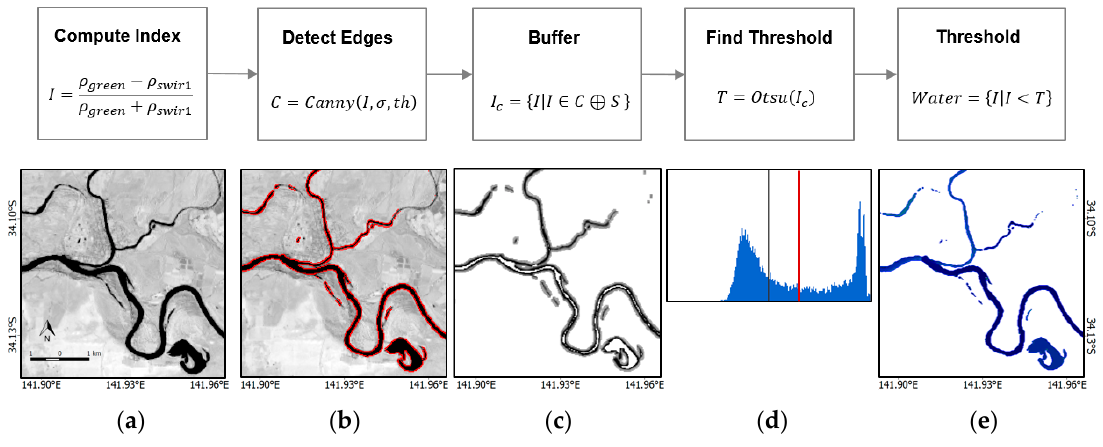
Figure 9. Method of water detection, consisting of the following steps: ( a ) compute water index; ( b ) compute edges using a Canny edge detector; ( c ) create a buffer around the edges using dilation; ( d ) compute threshold value using Otsu method, using only the pixels in the buffer ( e ) threshold index